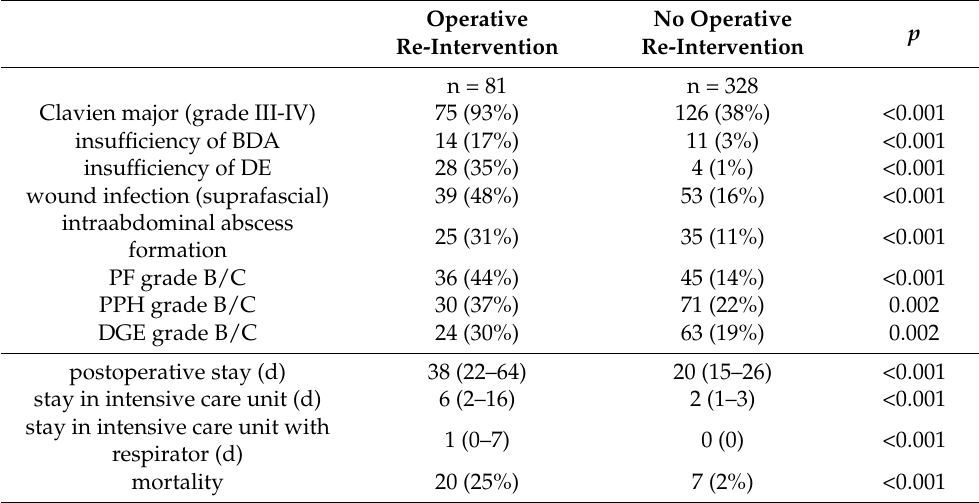
Table 3. Postoperative outcome/complications of index operation.